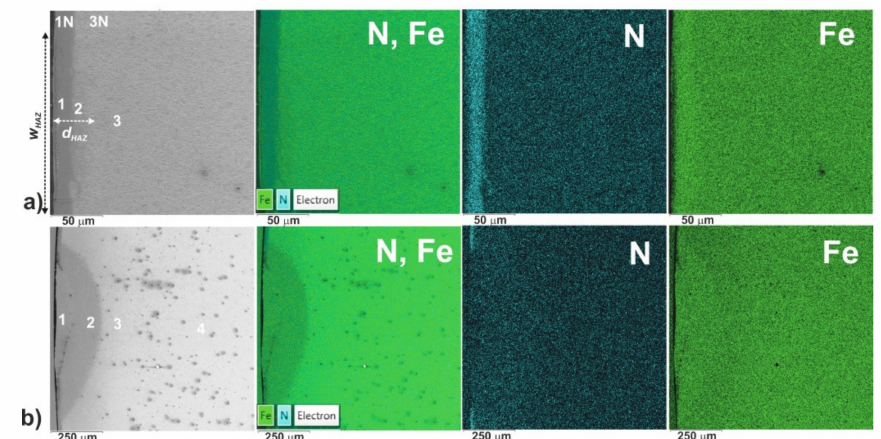
Figure 4. SEM images of single laser tracks and corresponding EDS patterns of iron and nitrogen after gas nitriding and LHT: without remelting using P = 0.234 kW and v l = 3.84 m · min − 1 ( a ) and with remelting using P = 0.624 kW and v l = 2.88 m · min − 1 ( b ); 1—compound zone without visible e ff